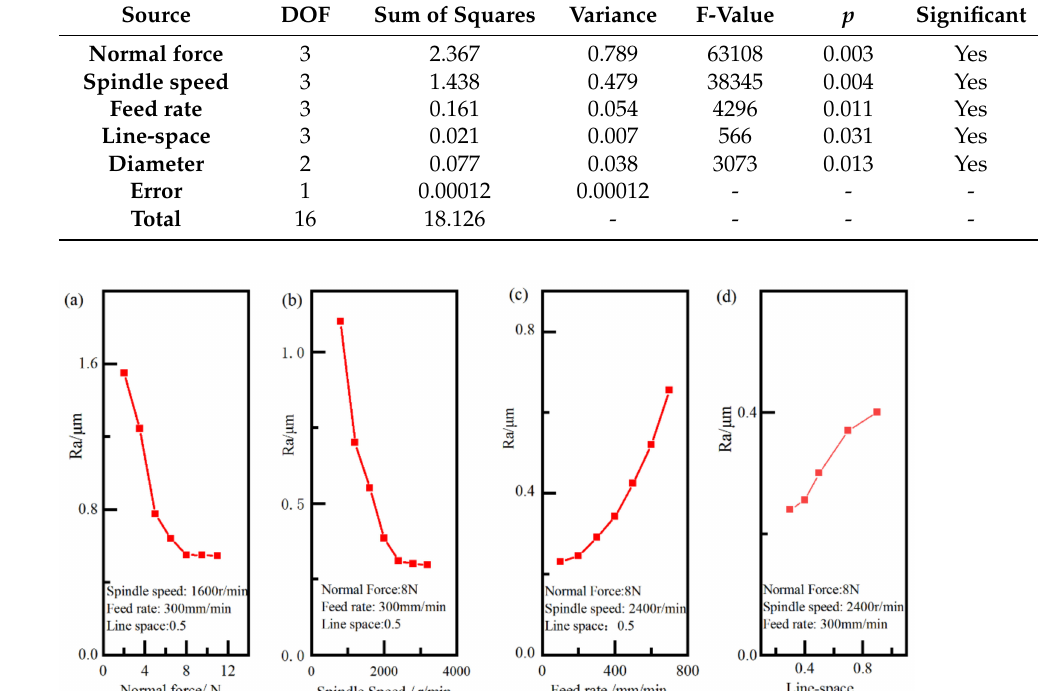
Figure 6. Main effect plots of process parameters on the surface